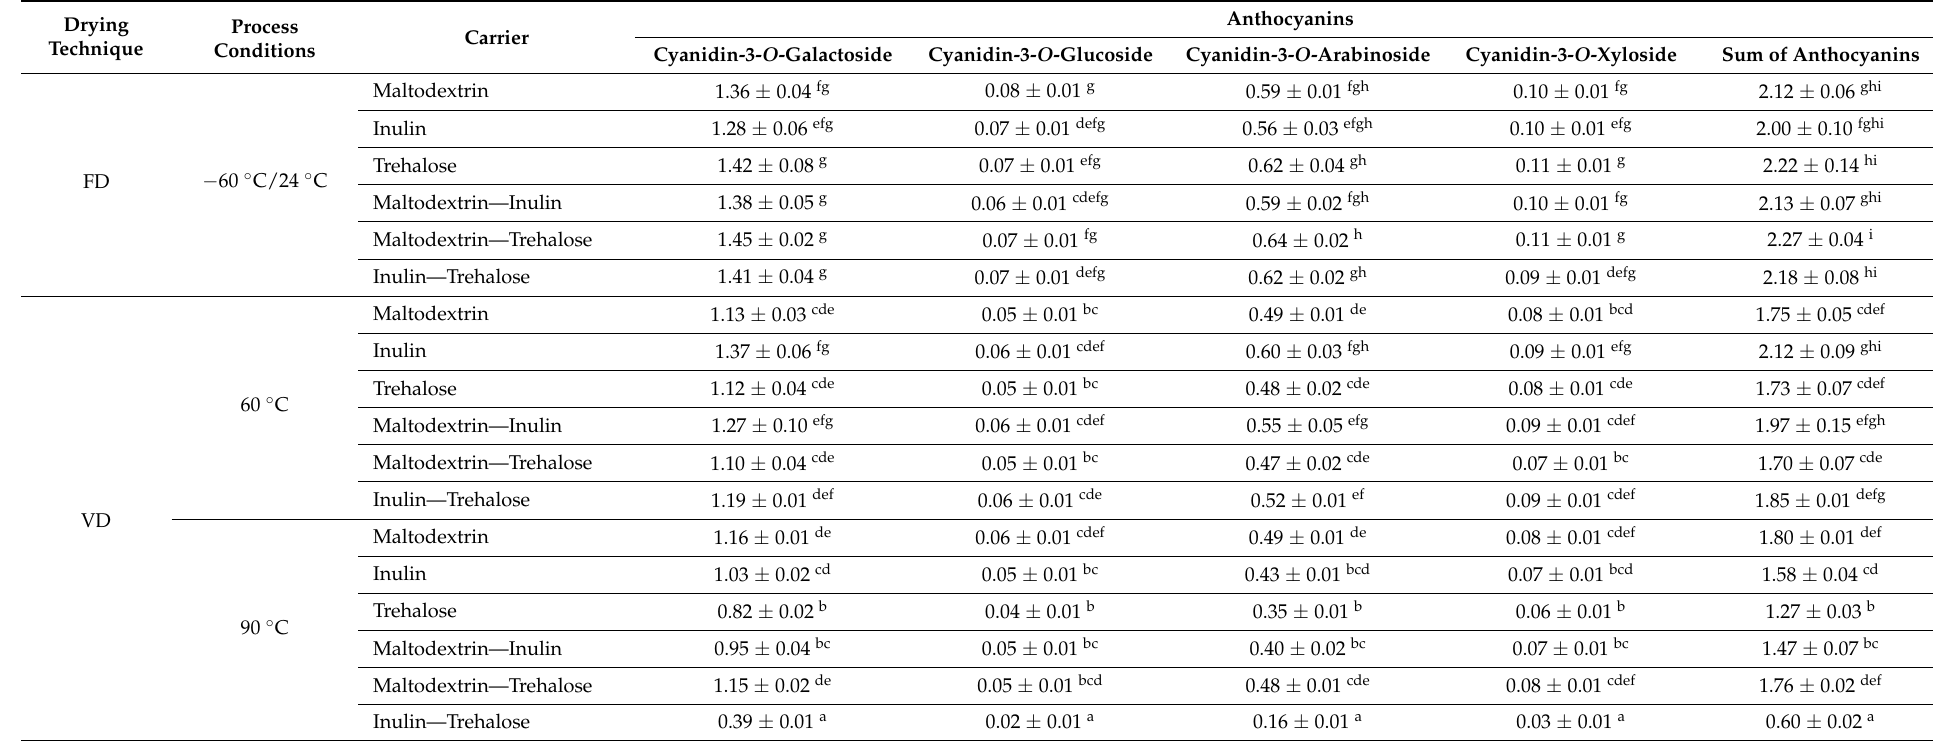
Table 3. The content of identified anthocyanins in chokeberry pomace extracts powders (g/100 g db) ( n = 2; average ± standard deviation). Drying